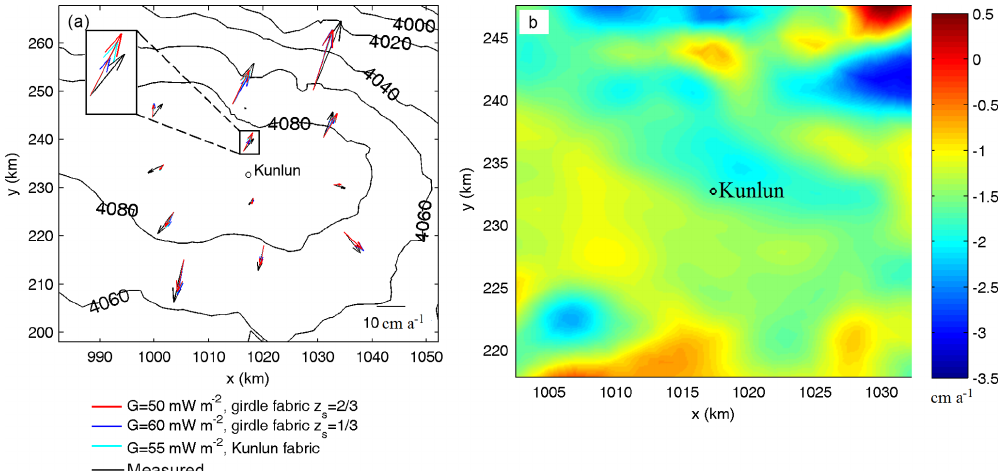
Figure 7. (a) Surface topography with contours, and the measured (black arrows; Yang et al., 2014) and modeled surface horizontal velocity (see legend for details) near Kunlun station. Kunlun station is marked by a black circle. The coordinate system is WGS 1984 plotted using Antarctic polar stereographic with standard parallel at 71 ◦ S and central meridian at 0 ◦ E. The inset box is a close-up of one velocity datum showing the differences between ice fabrics. (b) Modeled surface vertical velocities (unit: cma − 1 ) using Kunlun fabric, a geothermal heat flux of 55mWm − 2 , and a surface temperature of − 58.5 ◦ C. Note the region plotted in (b) is the central 30 × 30km 2 area while in (a) it is the larger 70 × 70km 2